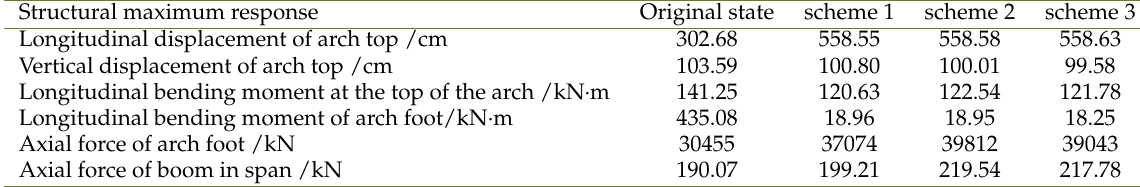
Table 7. Maximum response of structure under lateral